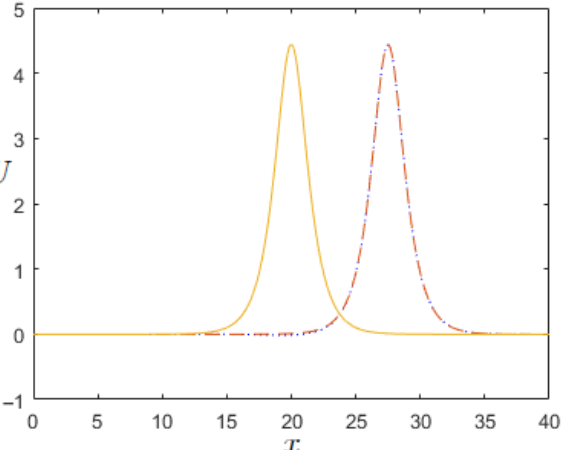
Figure 1. U computed by the numerical scheme ( 6 ) – ( 8 ) with h = 0.1 and τ = 0.0125. Comparison between the exact solution and the numerical solution at time T = 5. Initial condition (solid line); exact solution (dotted line); and numerical solution (dashed line).